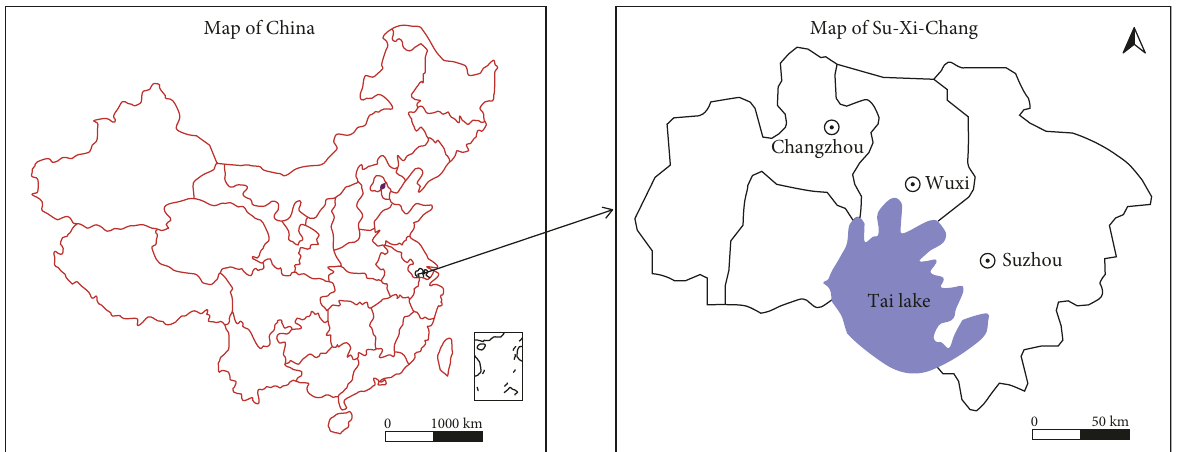
Figure 2: Map of the Su-Xi-Chang area in